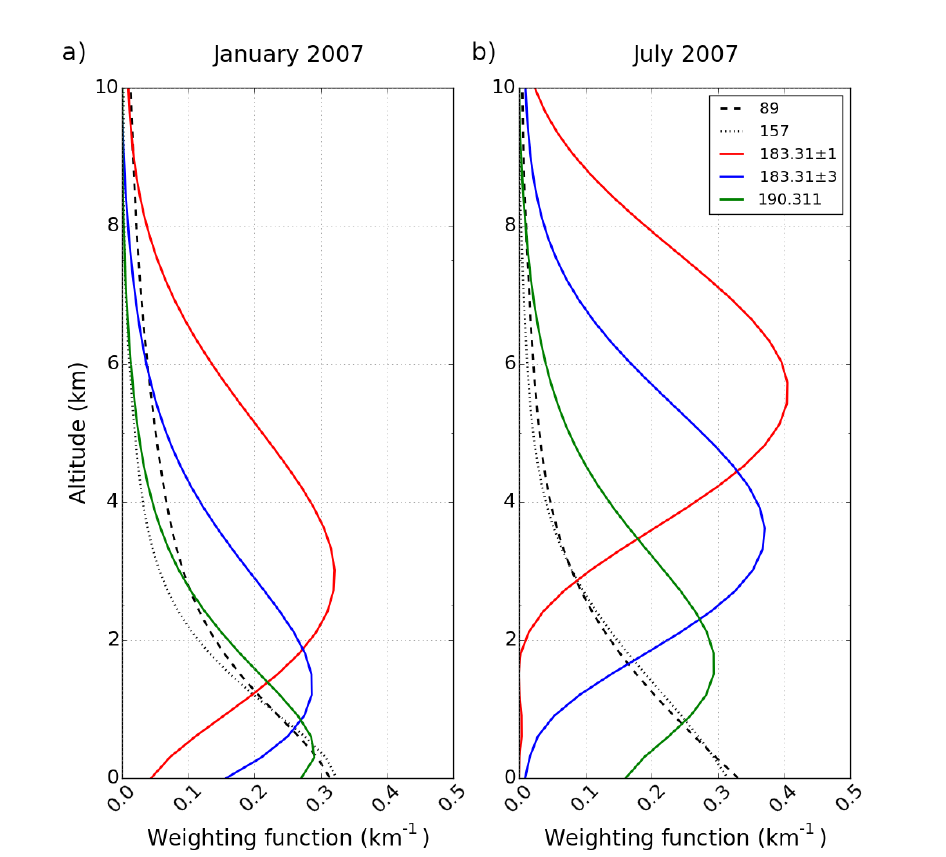
Figure 1. Clear-sky weighting functions for the MHS channels for a polar atmosphere (over Svalbard) in ( a ) January and ( b ) July 2007. The weighting functions were calculated using RTTOV Version 12 for the nadir view and then smoothed with a polynomial